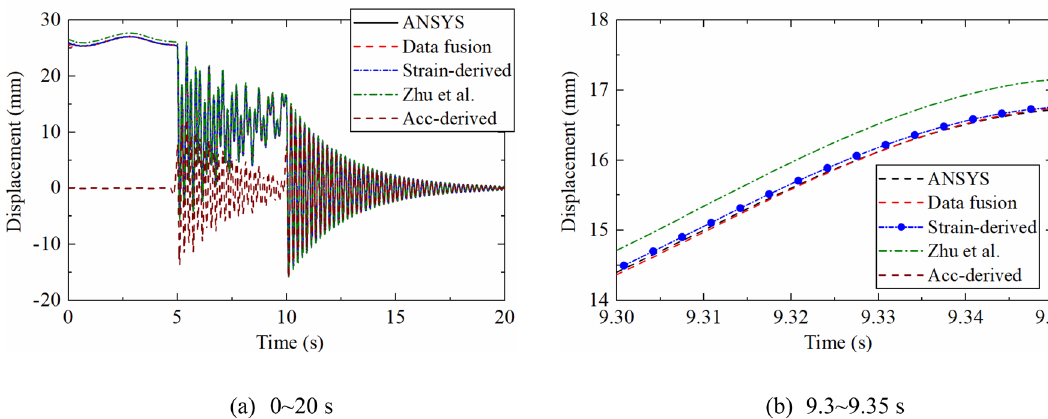
Figure 6. Dynamic displacement reconstructed by different